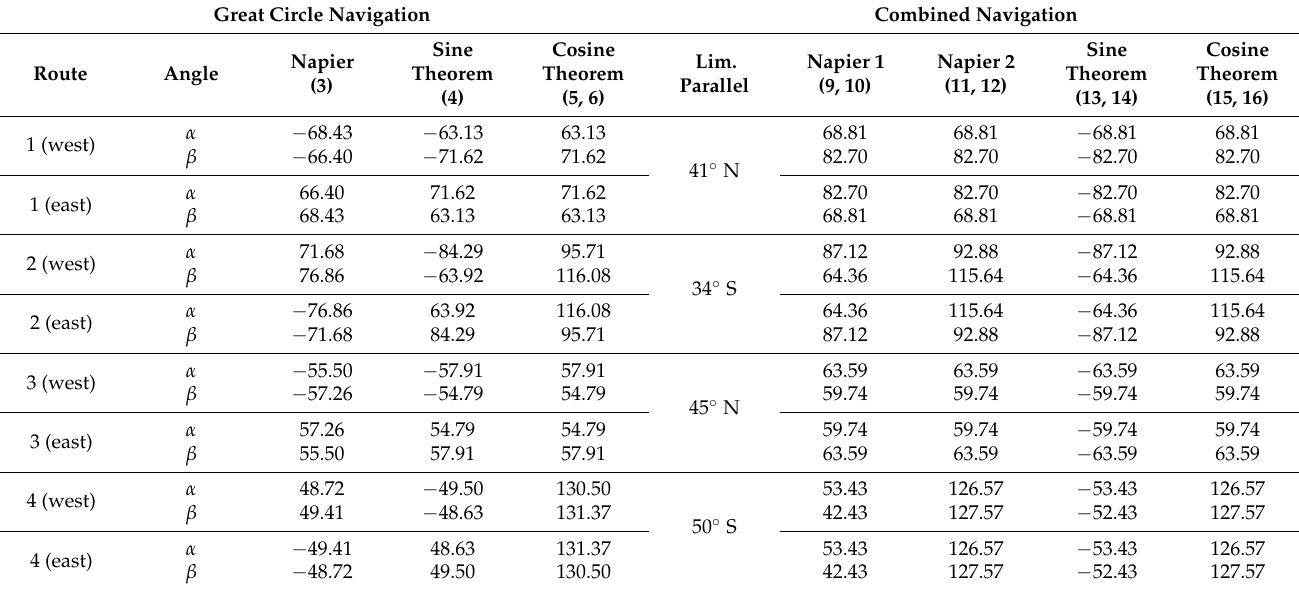
Table 2. Results of the calculated angles α and β between selected pairs of positions using different expressions. Great Circle Navigation